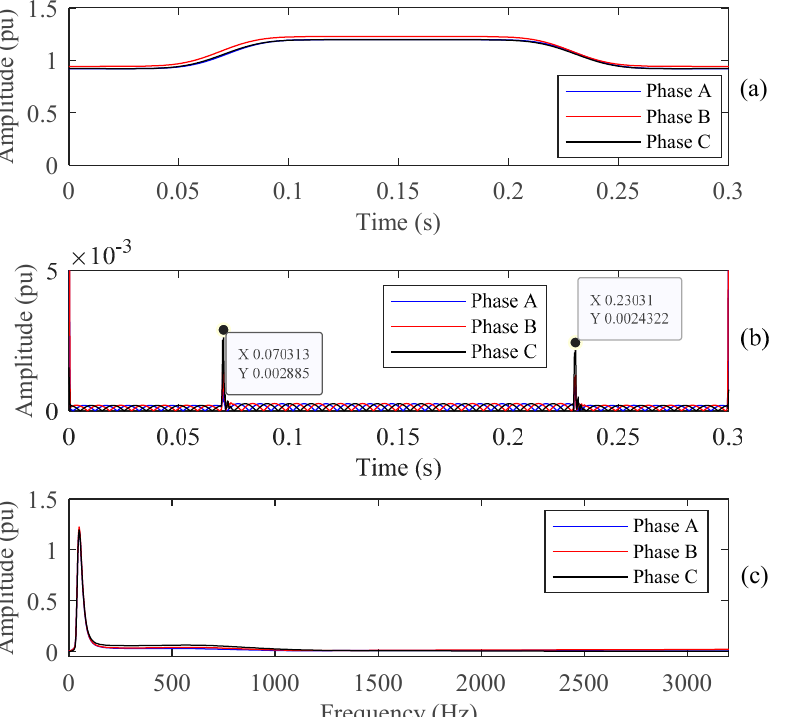
Figure 17. Related STA plots of PQ event at bus node 634 when the three-phase voltage increases from